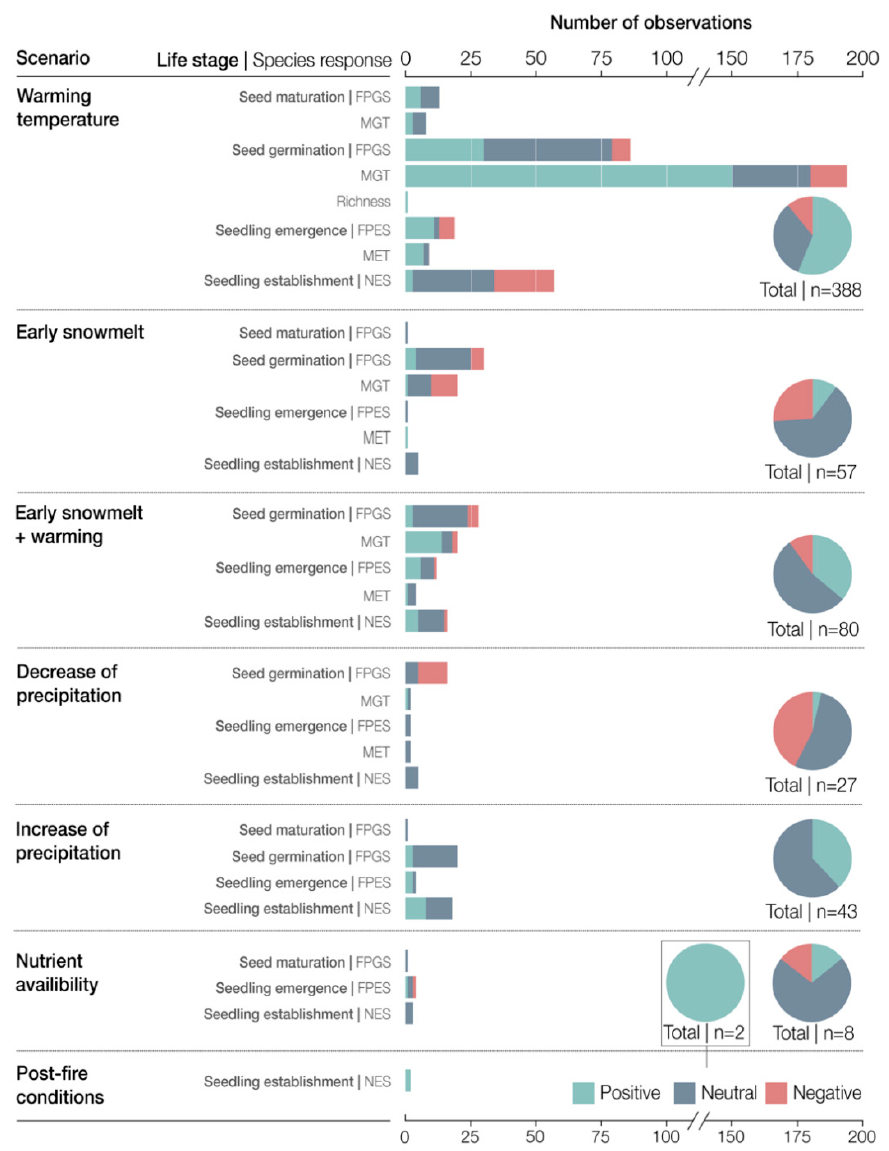
Figure 4. Distribution of positive, negative and neutral observations reported by the studies included in our review regarding the effects of climate change on early life-history stages of high altitude and high latitude plants. FPGS: final proportion of germinated seeds, MGT: mean germination time, FPES, final proportion of emerged seedlings, MET: mean emergence time, NES: number of established seedlings.